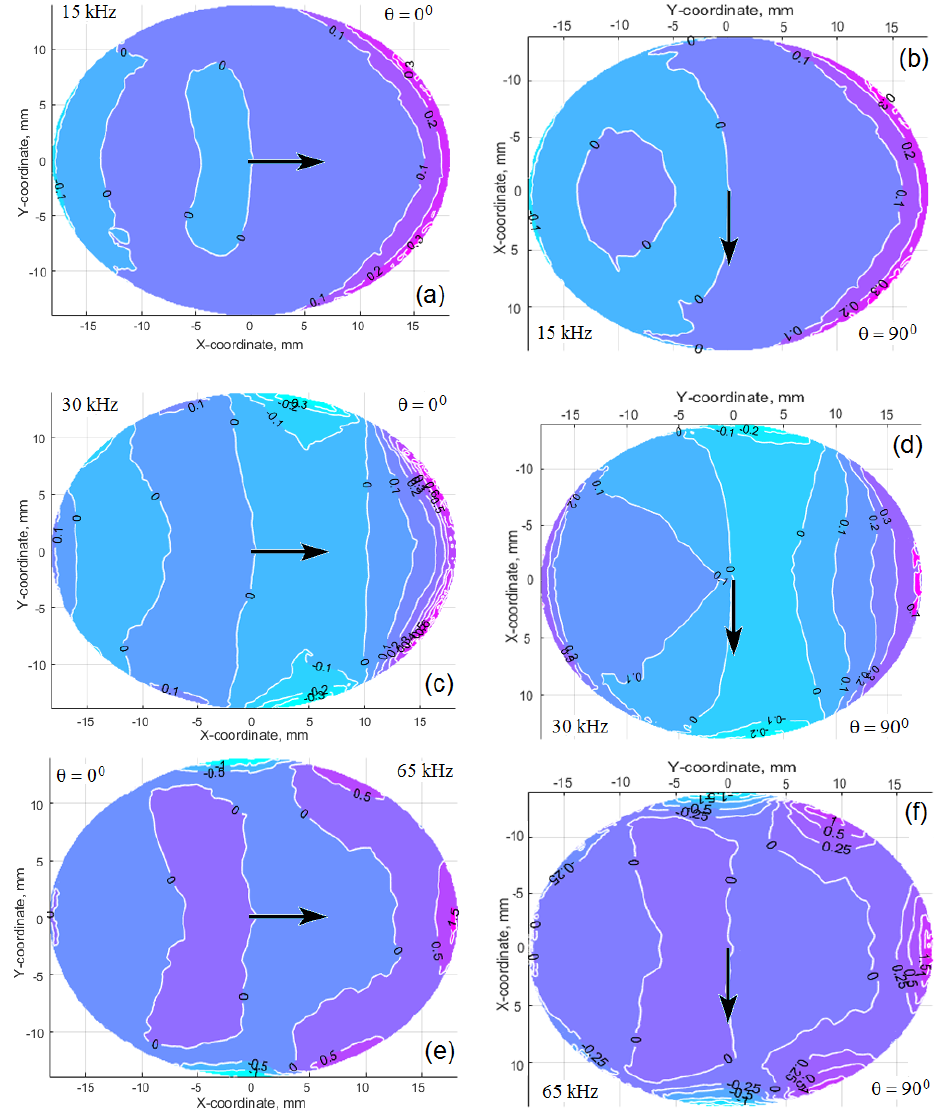
Figure 12. In-plane contact radial stress distributions (amplitude values in MPa) for the waves excitation frequencies 15 kHz ( a , b ), 30 kHz ( c , d ), and 65 kHz ( e , f ) at the actuator orientation along ( a , c , e ) and across ( b , d , f ) the main axis of orthotropic panel, which is denoted by the arrows.